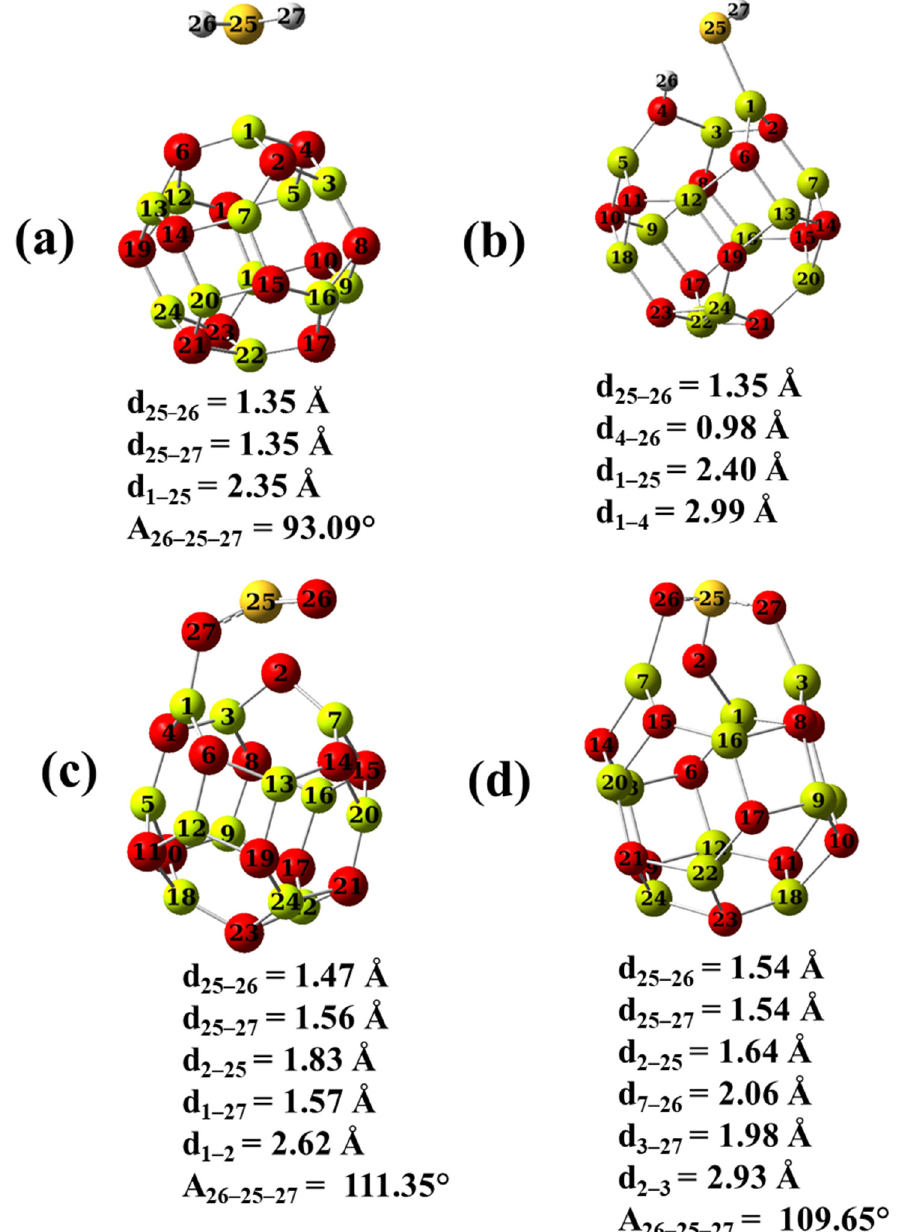
Figure 5. The optimal structures for ( a ) H 2 S/Be 12 O 12 , ( b ) H 2 S/Mg 12 O 12 , ( c ) SO 2 /Be 12 O 12 , and ( d ) SO 2 /Mg 12 O 12 complexes. Table 2 list the adsorption properties of H 2 S and SO 2 . Notably, the DFT-D3 calculations give more negative adsorption energy values than DFT calculations. Table 2. Adsorption properties of H 2 S as well SO 2 on Be 12 O 12 and Mg 12 O 12 nano-cages. Adsorption energies (E ads. , eV), Basis set superposition error (BSSE, eV), corrected adsorption energy ( E (cid:2911)(cid:2914)(cid:2929)(cid:2913)(cid:2925)(cid:2928)(cid:2928) ,eV), HOMO and LUMO energy levels (eV), HOMO- LUMO gap (E g , eV), NBO charges (Q, e), and dipole moment (D, Debye).